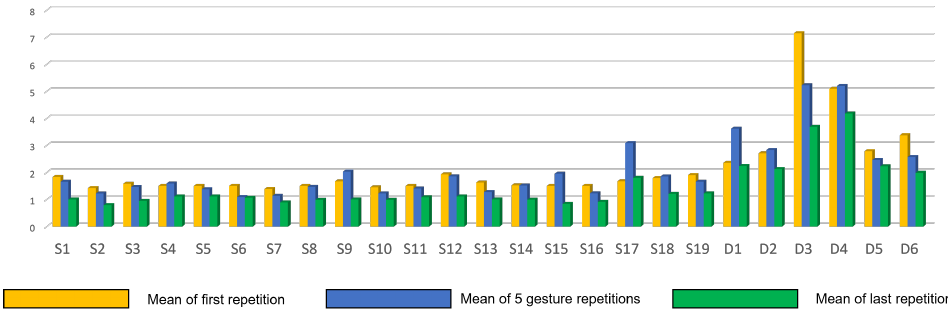
Figure 8. Mean time required by the subjects to perform the individual gestures. The time given refers to the moment when the gesture was recognized by the system after it was displayed to the participant. Mean time for the first time a gesture was performed in yellow, five repetitions of a single gesture is shown in blue, and the last repetition in green.